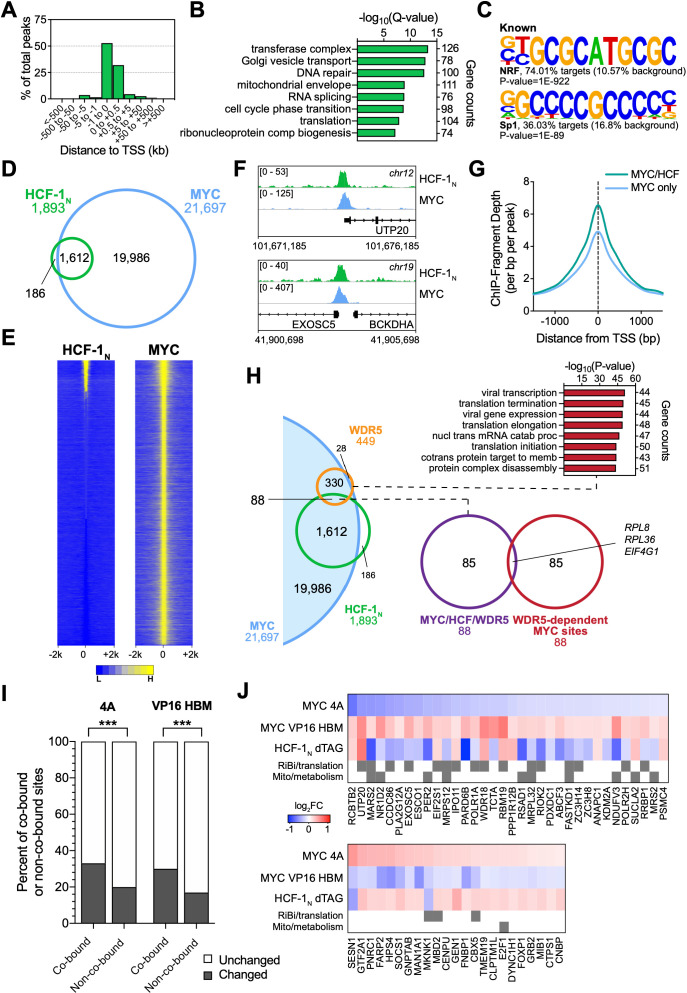
MYC is a widespread binding partner of host cell factor (HCF)–1 on chromatin.(A) Distribution of HCF-1N peaks in Ramos cells in relation to the nearest transcription start site (TSS), as determined by ChIP-Seq. (B) Gene ontology (GO) categories strongly represented in genes nearest to HCF-1N peaks in Ramos cells. (C) Known motif analysis of HCF-1N peaks in Ramos cells. Two of the most highly enriched motifs are shown, as well as the percentage of target and background sequences with the motif, and the p-value. (D) Venn diagram showing HCF-1N and MYC peaks in Ramos cells, and the number of regions that overlap between the data sets. ChIP-Seq data for MYC are from GSE126207. (E) Heatmap of all MYC peaks in Ramos cells (from GSE126207) and the corresponding region in Ramos HCF-1N ChIP-Seq, representing the combined average of normalized peak intensity in ±2 kb regions surrounding the peak centers with 100 bp bin sizes. Ranking is by peak intensity in HCF-1N. (F) Example Integrative Genomics Viewer (IGV) screenshots of regions that have overlapping peaks for MYC and HCF-1N in Ramos cells. (G) Normalized MYC ChIP-Seq fragment counts where peaks overlap with HCF-1N (MYC/HCF), compared to where they do not overlap (MYC) in Ramos cells. Data are smoothed with a cubic spline transformation. (H) Venn diagram showing relationship between HCF-1N, MYC, and WDR5 peaks in Ramos cells, and the overlap between co-bound genes and genes for which WDR5 is responsible for MYC recruitment. GO enrichment analysis of genes co-bound by MYC and WDR5—taken from Thomas et al., 2019—is also shown. (I) The proportion of protein-coding genes that were co-bound by promoter-proximal MYC and HCF-1N by ChIP-Seq or an equal number of non-co-bound genes were compared to transcripts that were unchanged or significantly changed (false discovery rate [FDR] < 0.05) with the 4A and VP16 HCF-1-binding motif (HBM) mutants by RNA-seq. p-Value for the 4A mutant is 1.982 × 10−14 and 6.933 × 10−14 for the VP16 HBM mutant. (J) Heatmap showing genes that are co-bound by promoter proximal MYC and HCF-1N in Ramos cells, have anti-correlative gene expression changes between for the 4A and VP16 MYC mutants, and have significant gene expression changes with HCF-1N degradation. Genes that fall into GO categories relating to ribosome biogenesis or translation (RiBi/translation), and mitochondrial function or metabolism (Mito/metabolism) are highlighted.Figure 5—source data 1.Ramos host cell factor (HCF)–1N annotated ChIP-Seq peaks.Figure 5—source data 2.Annotated intersect of ChIP-Seq peaks for host cell factor (HCF)–1N and MYC in Ramos cells.